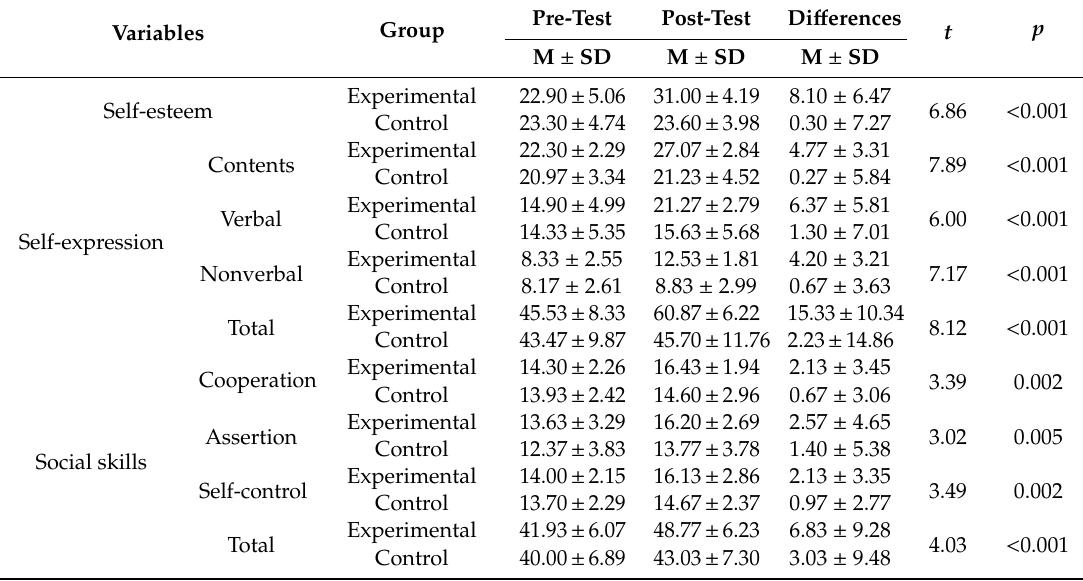
Table 4. Comparison of self-esteem, self-expression, and social skills between the groups. Variables Group